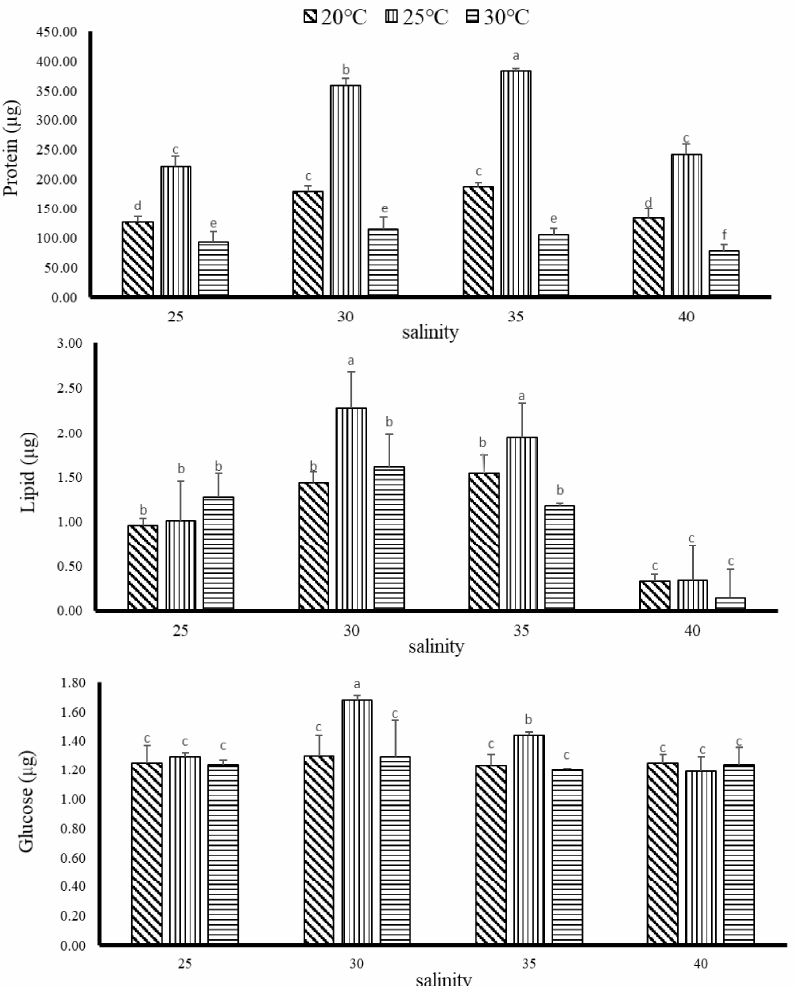
Figure 4. Effects of 8 weeks of rearing at different temperatures and salinities on the composition of G. columna . Each value represents ±SD ( n = 3). The Latin alphabet represents significant differences ( p < 0.05).